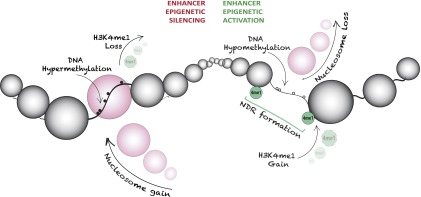
Model depicting mechanisms by which the distal regulatory architecture provides an additional layer of epigenetic plasticity in cancer. Enhancers preferentially undergo epigenetic silencing, which is exemplified by collapse of a NDR (nucleosome gain), DNA hypermethylation, and loss of the H3K4me1 mark. Epigenetic switching can also encompass aberrant epigenetic activation of enhancers. Here, an atypical NDR is formed due to nucleosome loss, and the enhancer becomes marked by H3K4me1, which is accompanied by DNA hypomethylation events in the cancer cells. Our data indicate that many more enhancers are abnormally silenced than activated, consistent with the hypothesis that it is more difficult to activate an already silenced regulatory element than it is to silence an already active or poised regulatory element. These findings also support a permanently silenced state in cancer. Thus, our data demonstrate that the global epigenetic landscape is dynamically altered at key regulatory regions outside of promoters. (NDR) Nucleosome-depleted region; (small white circle) unmethylated CpG site; (small black circle) methylated CpG site; (large circle) nucleosome; (4me1 [green]) H3K4me1.